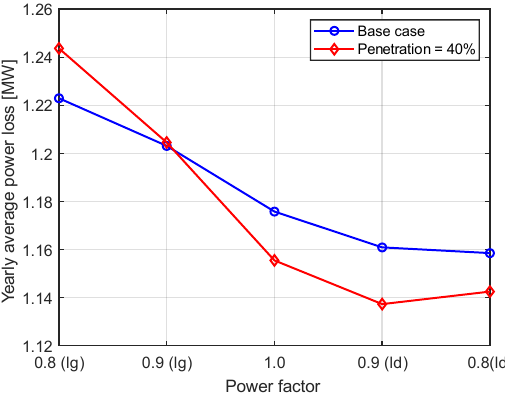
Figure 7. The yearly average power loss of the entire grid at different PF setpoints (with constant PF ).